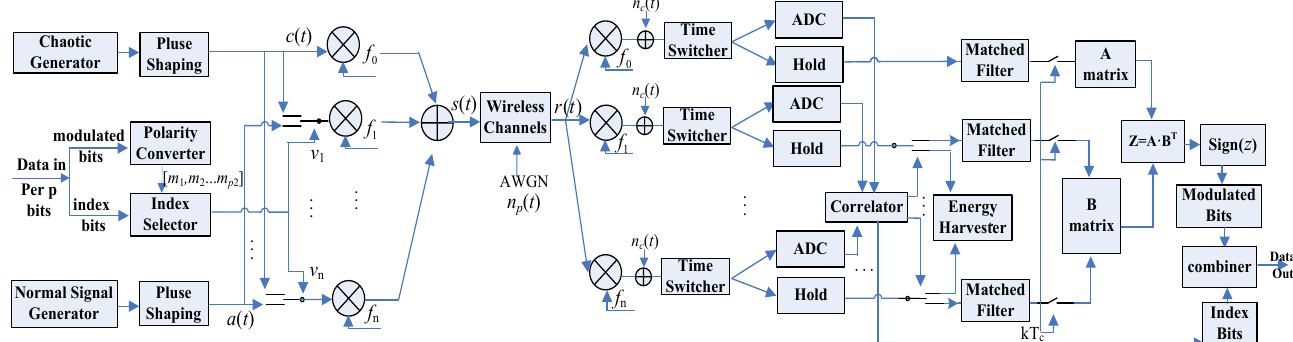
Figure 1. Block diagram of the GCI-DCSK SWIPT